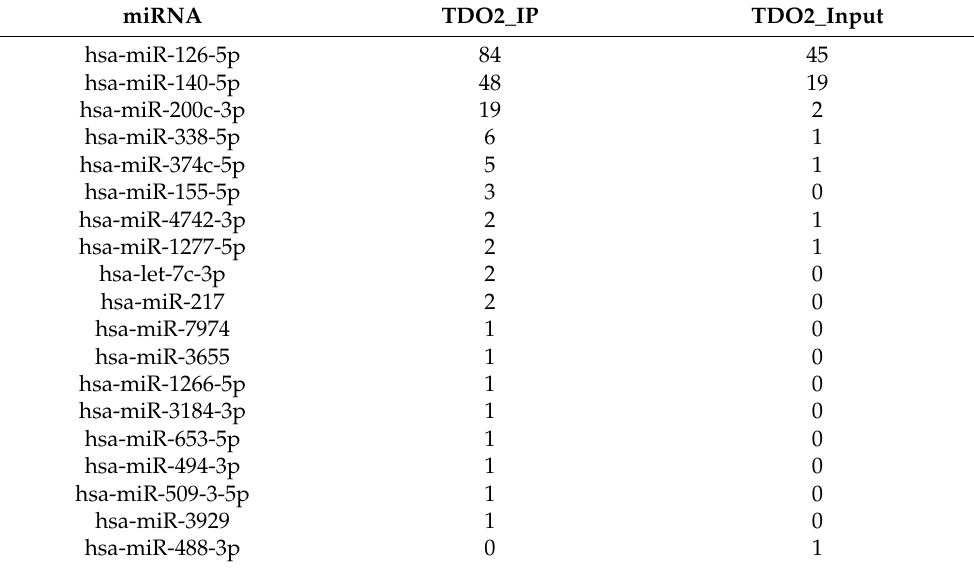
Table 3. The expression of the 19 known miRNAs matched.